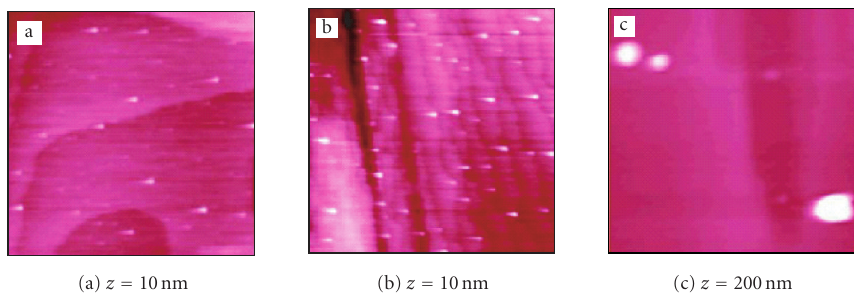
Figure 9: AFM topographies (5 μ m) on (001) of phthalimide ( 10 ) at room temperature: (a) fresh from acetone; (b) after 2d in air at relative humidity of 50–60%; (c) after 16h storage in a vacuum near the saturation pressure of water at room temperature.